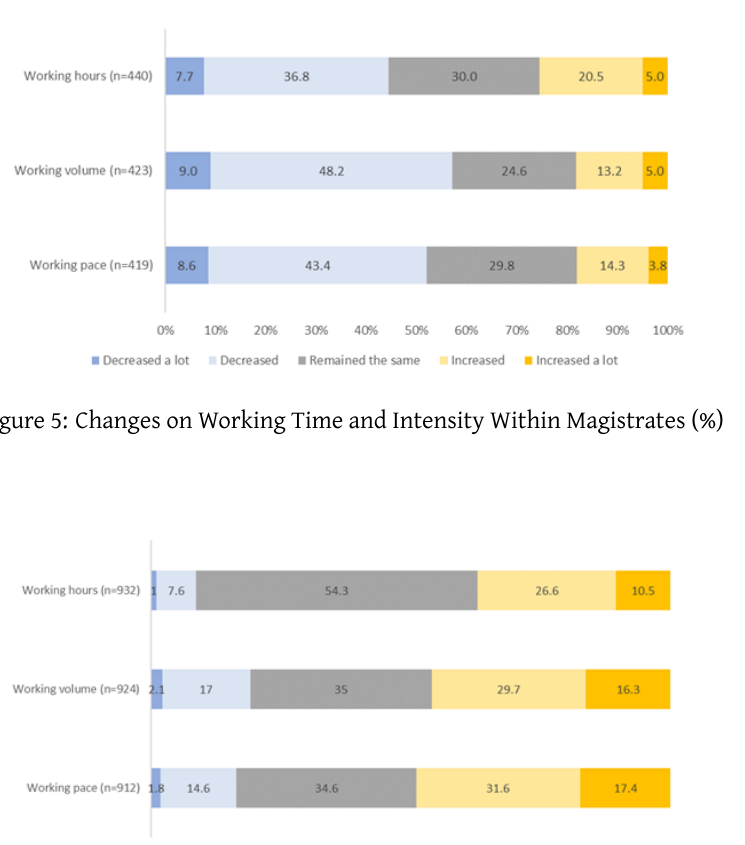
With the courts partially closed and the activity reduced to urgent cases, the functions performed by the magistrates were the most affected, while the secretarial service could